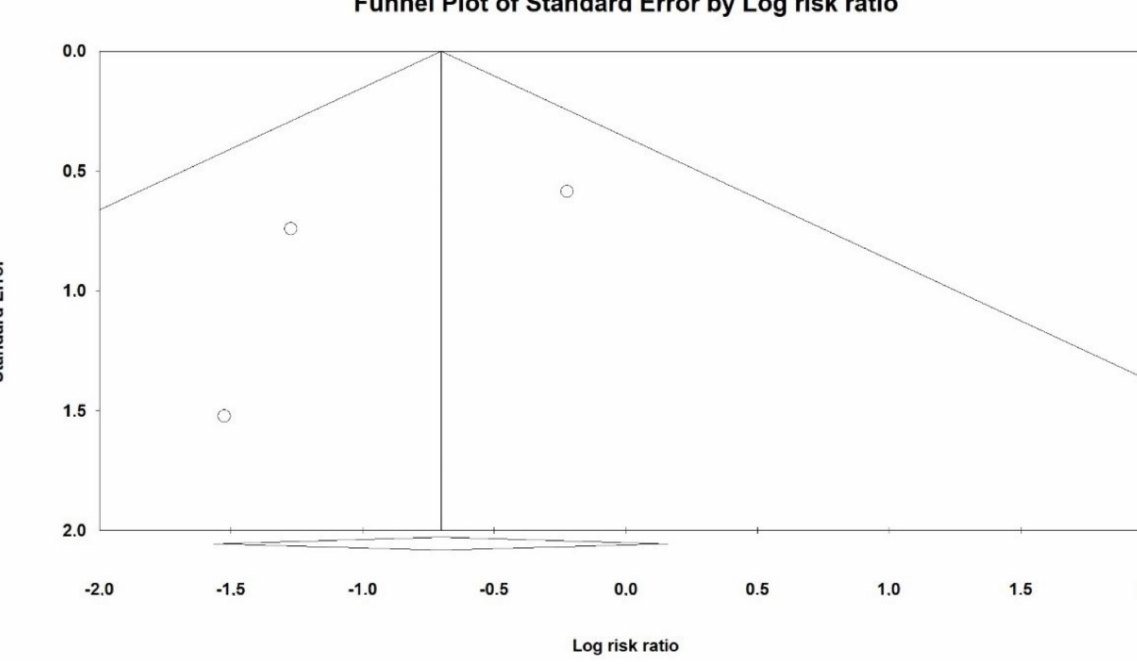
Figure 8. Funnel plot for mortality (RR) in present